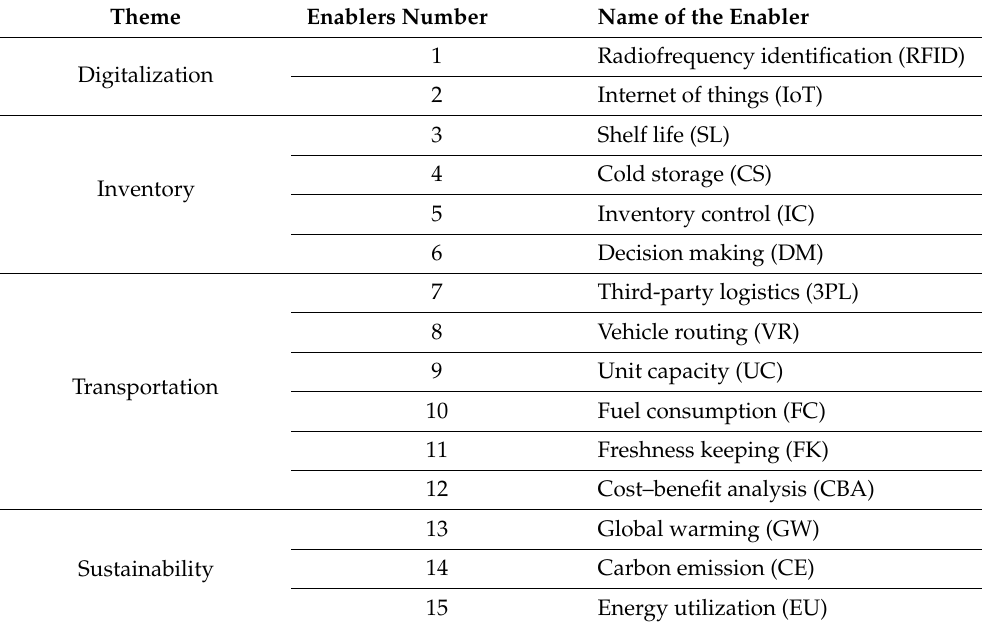
Table 1. Fifteen enablers from Vosviewer keyword co-occurrence